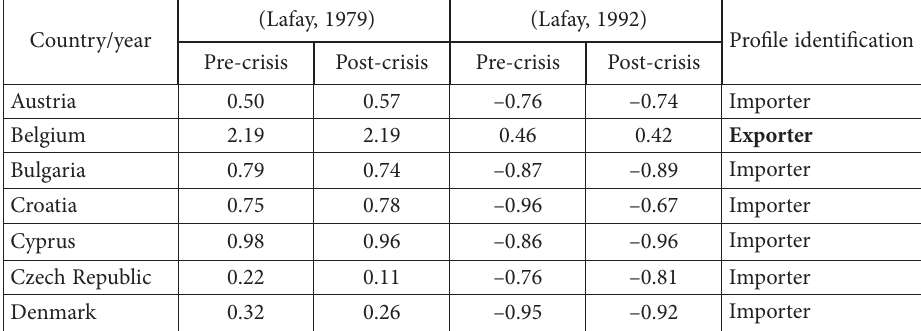
Table 1. Identification of profiles in the countries of the European tomato market Pre-crisis (2005–2010) and Post-crisis (2011–2016) (source: own elaboration based on COMTRADE, 2018